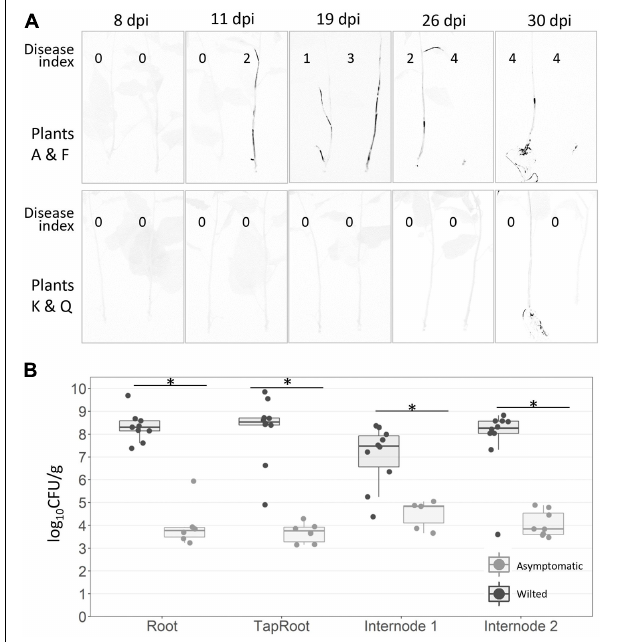
FIGURE 2 | Bacterial colonisation and multiplication in stem-inoculated S. dulcamara and tomato cv. Marmande plants. (A) Non-destructive live luminescence imaging of four representatives S. dulcamara plants throughout a 30-day period after root inoculation with a luminescent R. solanacearum strain. Two symptomatic (A & F) and two asymptomatic (K & Q) plants are shown. Luminescent bacteria are detected in darker areas. Wilting symptoms (Disease index = 0–4) are indicated next to each plant inside the images. (B) R. solanacearum concentrations measured at the root, taproot, internode 1 (2–3 cm above the inoculation point) and 2 (6–9 cm above the inoculation point) in S. dulcamara plants uprooted 30 days post-inoculation (dpi) with the luminescent reporter strain. The results from asymptomatic (disease index 0) and symptomatic (disease index 1–4) plants are shown separately. Bacterial counts were calculated from tissue luminescence and are expressed as log CFUs · g − 1 tissue. ∗ indicates statistical differences ( p -value < 0.05, T -student significant